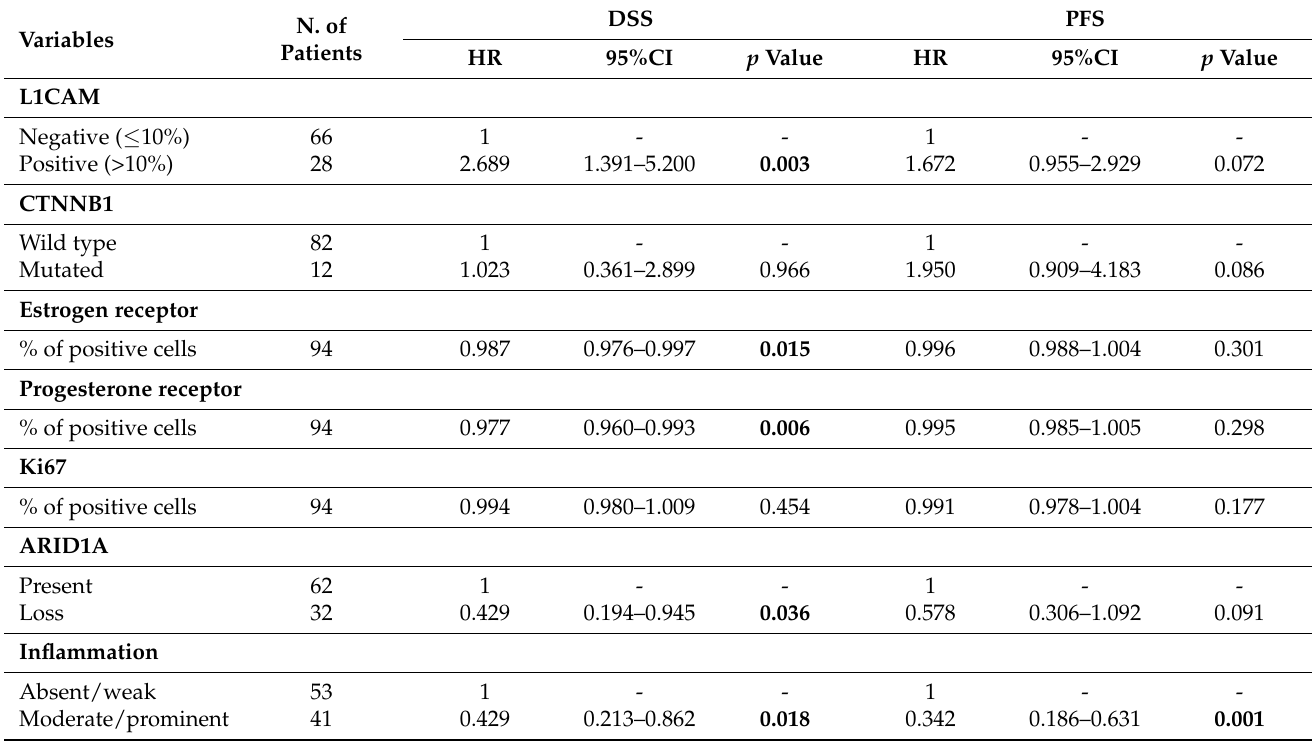
Table 4. Univariable survival analysis for disease-specific survival (DSS) and progression-free survival (PFS) accounting for additional molecular/pathological biomarkers on the whole Brescia cohort of 94 EC